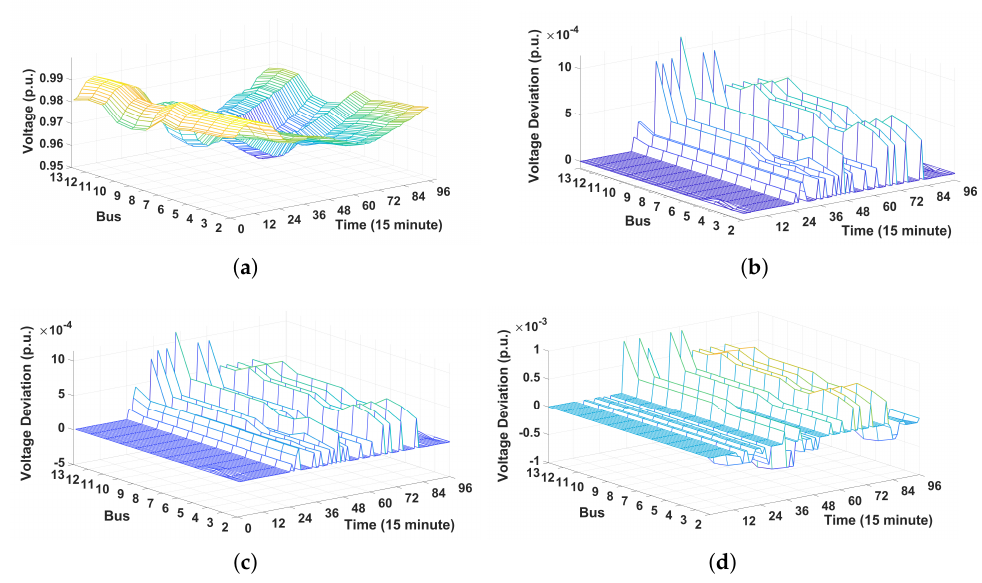
Figure 9. Voltage profile and voltage deviation for 12 buses during 24 h. ( a ) Voltage magnitude after the MCS dispatch. ( b ) Voltage deviation ( ω 1 = 0.2, ω 2 = 0.8). ( c ) Voltage deviation ( ω 1 = 0.5, ω 2 = 0.5). ( d ) Voltage deviation ( ω 1 = 1, ω 2 = 0).